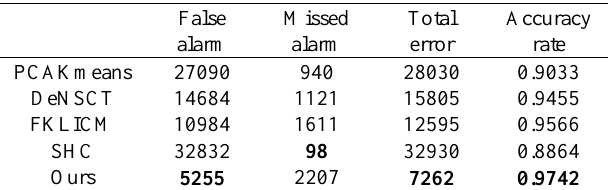
Table 1 Quantitative results of five methods (false alarm, missed alarm and total error stand for the number of pixels)